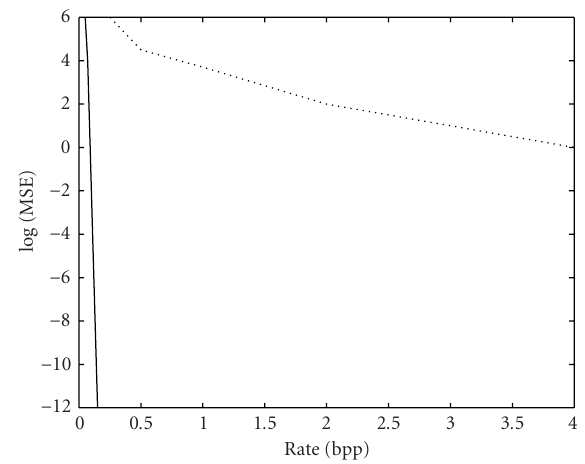
Figure 2: Operational rate-distortion curve comparison between subsource 0 (solid) and subsource 1